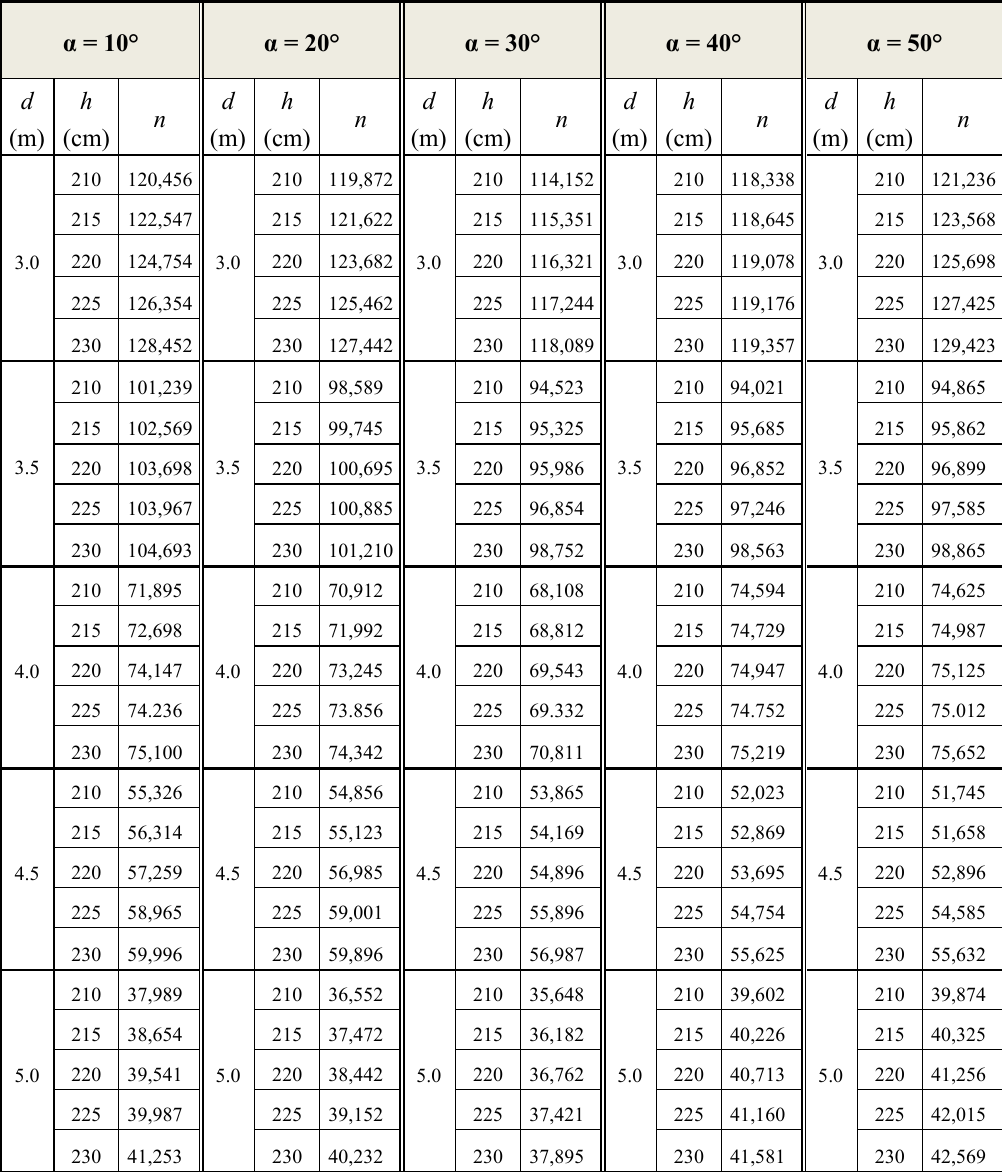
Table 1. Number of pixels ( n ) in the ROI obtained for different combinations in the pitch angle ( α ), height of the camera ( h ) and distance to the ROI ( d